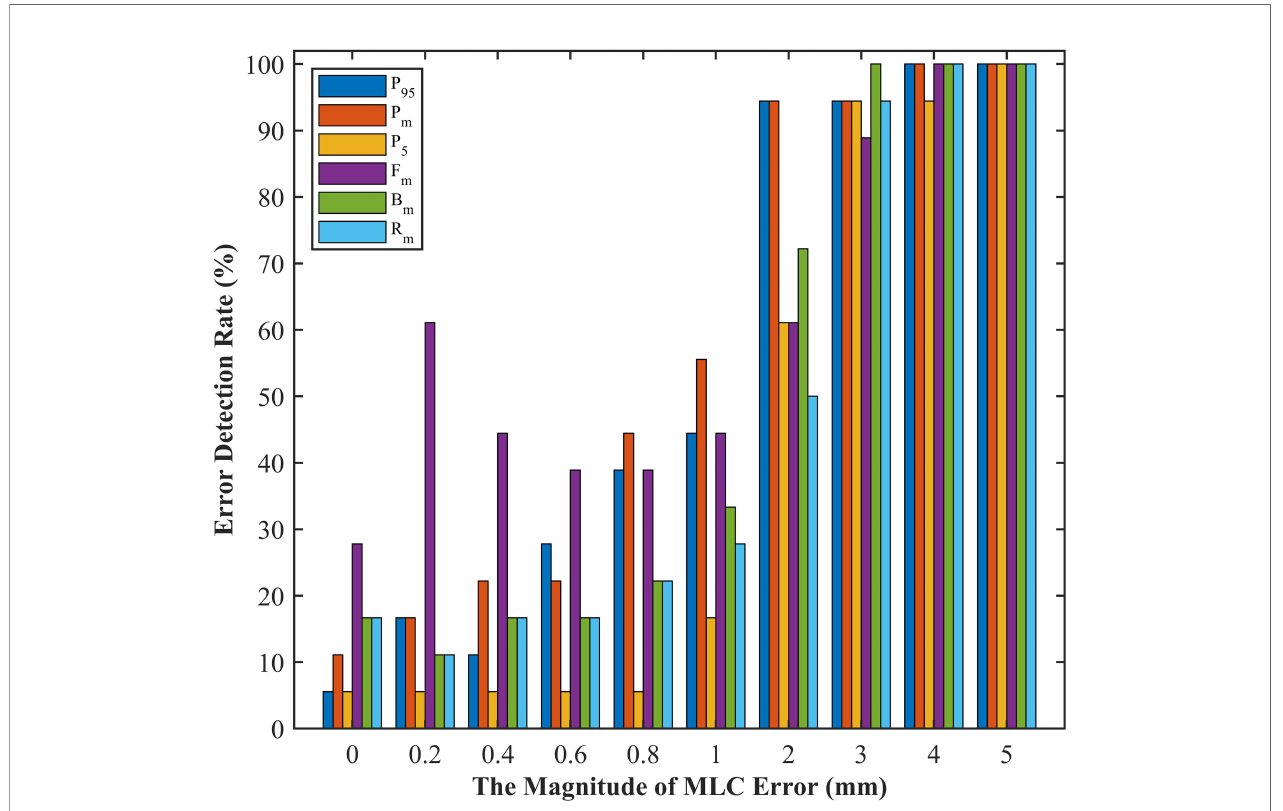
FIGURE 6 | The error detection rate of test plans in different magnitude of systematic MLC errors. P 5 , PTV 5 ; P 95 , PTV 95 ; P m , PTV mean ; B m , Bladder mean ; R m , Rectum mean ; F m , Femoral-heads mean .